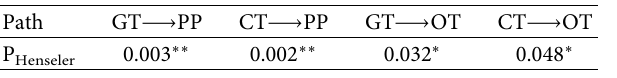
Table 9: Multigroup comparison test